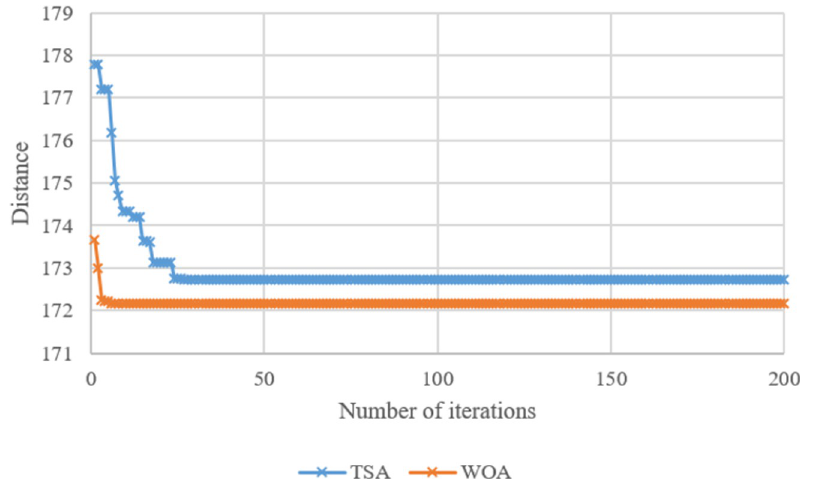
Fig 11. Search history of TSA and WOA for Case- 40